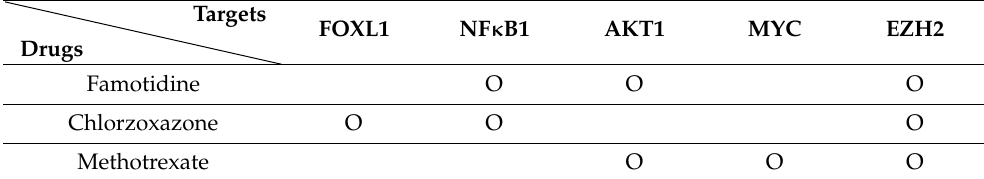
Table 3. The multiple-molecule drug and the corresponding target proteins for DLBCL GCB.